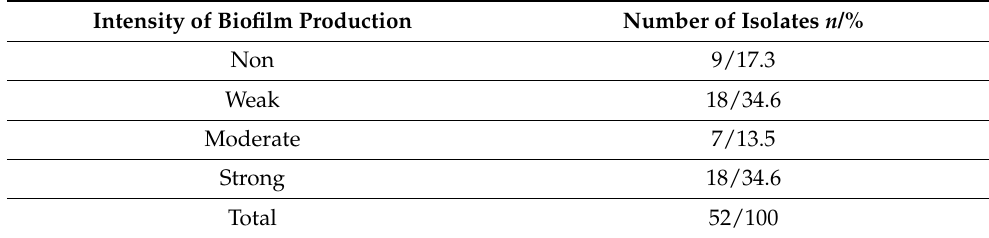
Table 2. Biofilm formation by M. pachydermatis strains.